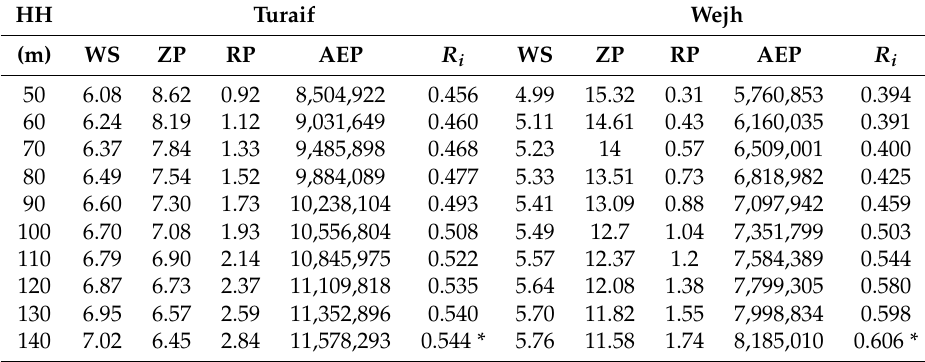
Table A11. TOPSIS analysis for turbine Nordex N131/3000. The best choice for each site is marked with an asterisk. HH Turaif Wejh